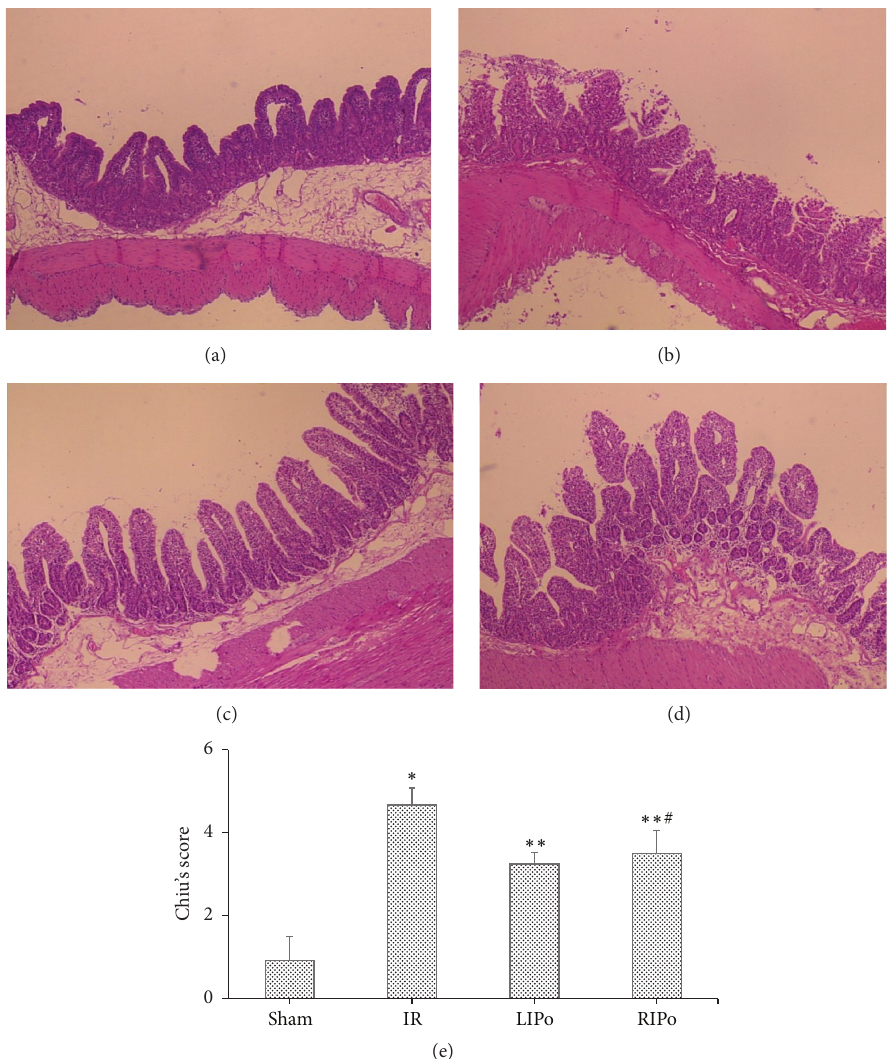
Figure 2: Histopathological changes of the intestinal mucosa and the evaluation of intestinal injury by Chiu scores (HE staining, magnification 200x). (a) Sham group. (b) I/R group. ((c) and (d)) LIPo and RIPo groups. (e) Changes of the intestinal mucosa Chiu scores. Data are presented as mean ± SD, 𝑛 = 6 . ∗ 𝑝 < 0.05 versus the sham group; ∗∗ 𝑝 < 0.05 versus the I/R group; # 𝑝 > 0.05 versus the LIPo